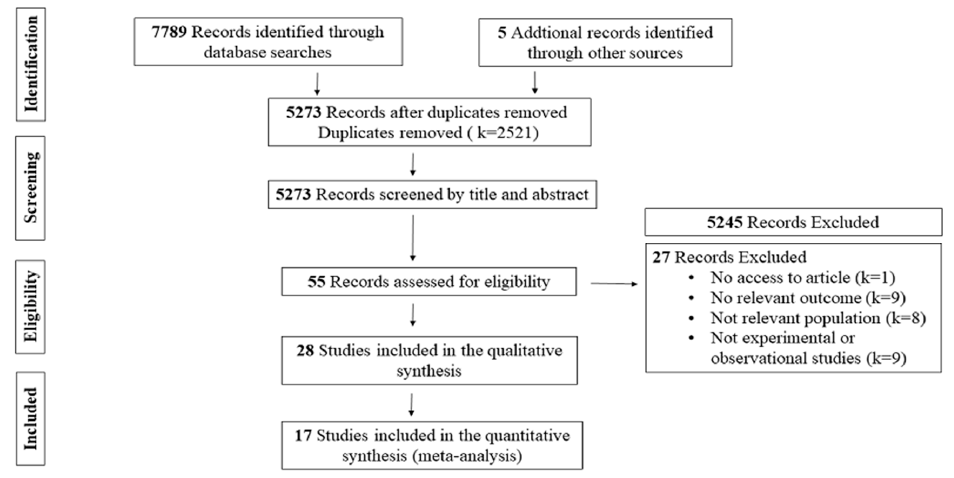
Figure 1. Flow chart of the methodology for the search results.